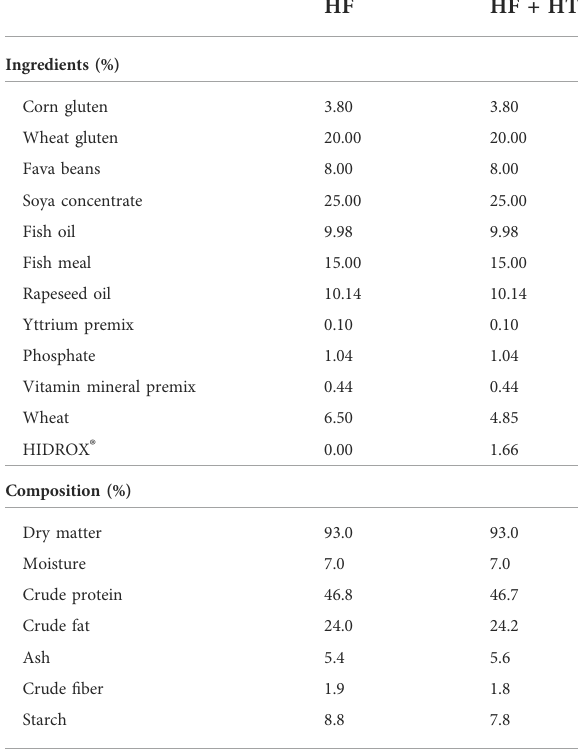
TABLE 1 Composition of the experimental high-fat diets without (HF) or with hydroxytyrosol (HF + HT). The hydroxytyrosol included in the formulation (0.52 g HT/kg feed) was provided by the commercial olive juice extract HIDROX ® (Oliphenol LLC., Hayward, CA, United States) that contains a > 12% of simple and total polyphenols from which 3.136% is